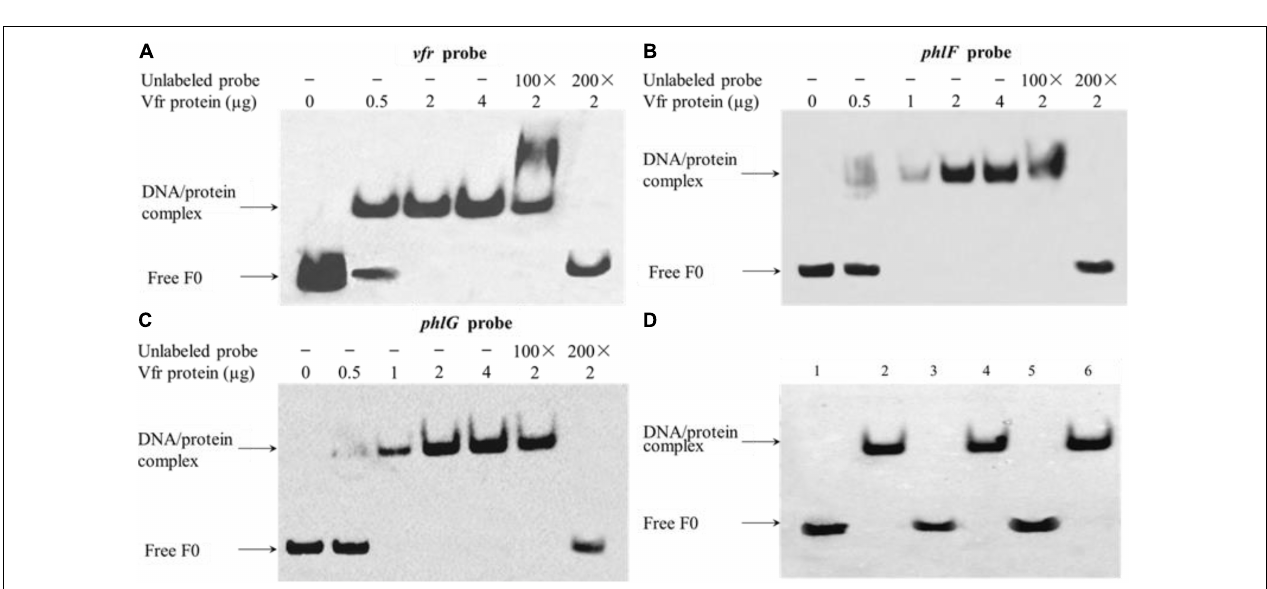
FIGURE 4 | DNA-binding specificity determined using the bacterial one-hybrid reporter system. The upstream sequences of vfr , phlF, and phlG were individually cloned into pBXcmT. The vfr gene was cloned into the vector pTRG. A pair of pTvfr/pBvfr plasmids was cotransformed into the reporter strain E. coli XL1-Blue MRF’ Kan, and the growth of the strain was then tested on a selective medium containing 3-AT, Km r , Str r , and Cm r as a positive control. The pTRG/pBvfr (pBphlF or pBphlG) plasmids were cotransformed into E. coli XL1-Blue MRF’ Kan as negative controls. Cotransformants with positive growth were selected on plates containing selective screening medium.